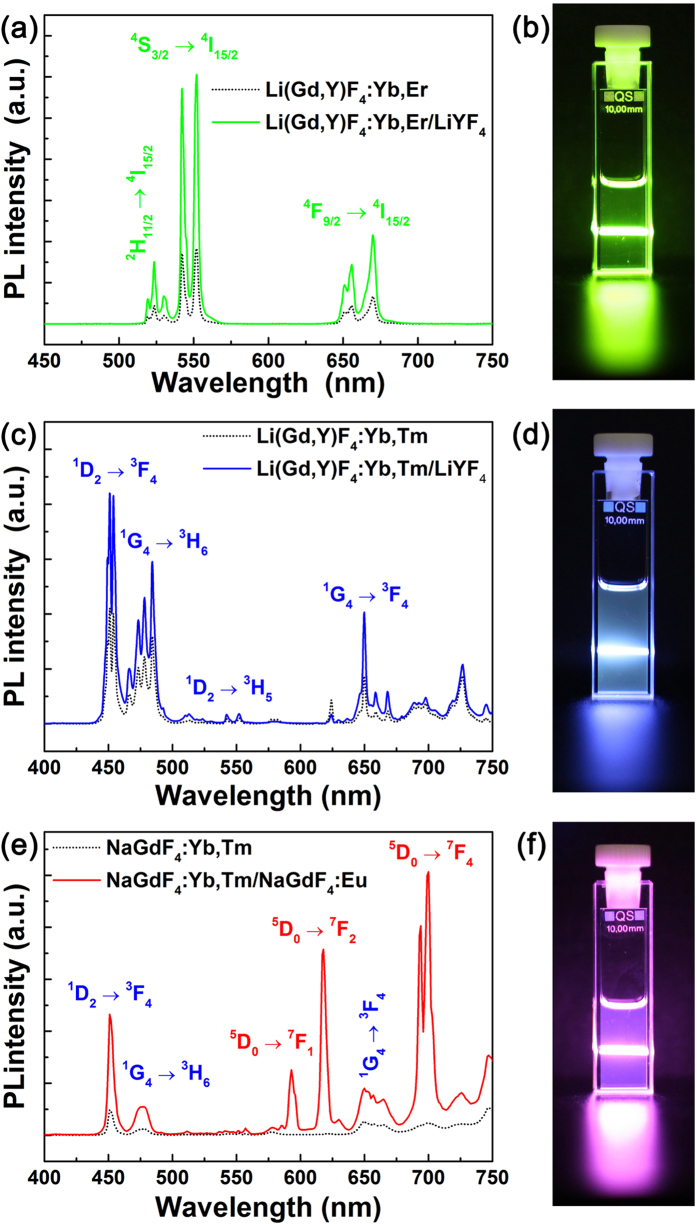
PL spectra of (a) Li(Gd,Y)F4:Yb,Er (dotted black line) and Li(Gd,Y)F4:Yb,Er/LiYF4 (solid green line), (c) Li(Gd,Y)F4:Yb,Tm (dotted black line) and Li(Gd,Y)F4:Yb,Tm/LiYF4 (solid blue line), and (e) NaGdF4:Yb,Tm (dotted black line) and NaGdF4:Yb,Tm/NaGdF4:Eu (solid red line). Photographs showing luminescence from (b) Li(Gd,Y)F4:Yb,Er/LiYF4, (d) Li(Gd,Y)F4:Yb,Tm/LiYF4, and (f) NaGdF4:Yb,Tm/NaGdF4:Eu C/S UCNP solutions under excitation with 980 nm NIR light.